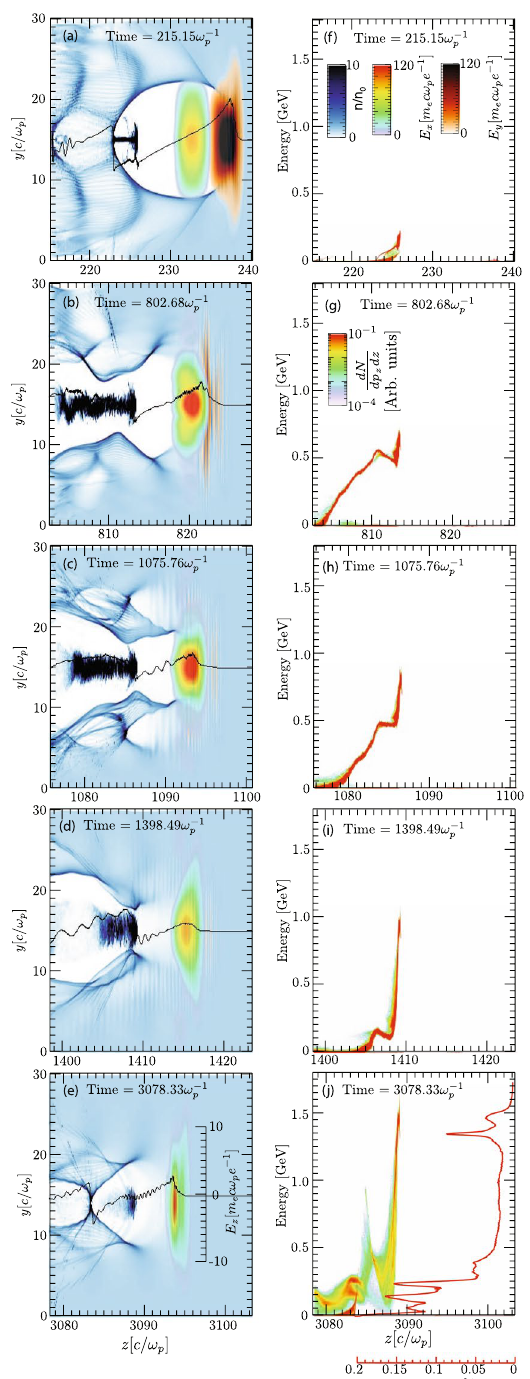
Figure 1. Proof-of-principle 3D PIC simulation. ( a – e ) Show the snapshots of laser fields and electron density distribution in the y-z plane at different times, and ( f – j ) show the energy-space distribution of accelerated electrons at respective times. The line in figures ( a – e ) is the longitudinal electric field ( E z ) on the laser axis. The red line in figure ( j ) represents energy spectrum of the electrons showing bunched electron beam around 1.4